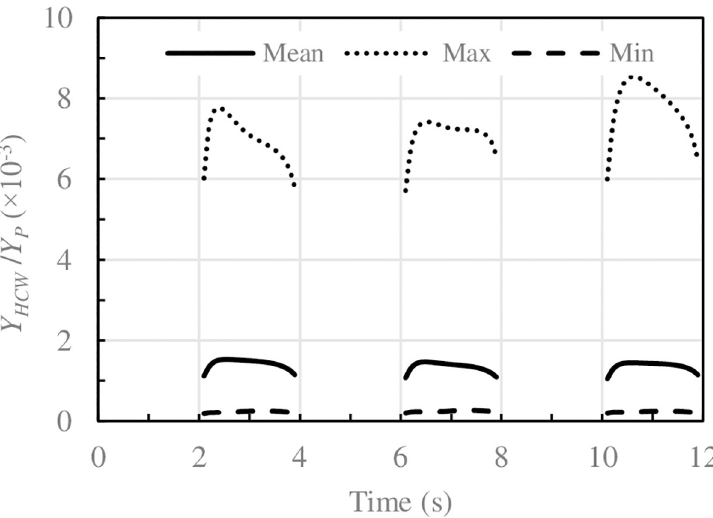
Fig 3. Concentration of N 2 O inhaled by the HCW for the case of EN_09. Solid lines: phase-average values, dotted lines: maximum value, dashed lines: minimum value corresponding to 75 cycles of 12s.